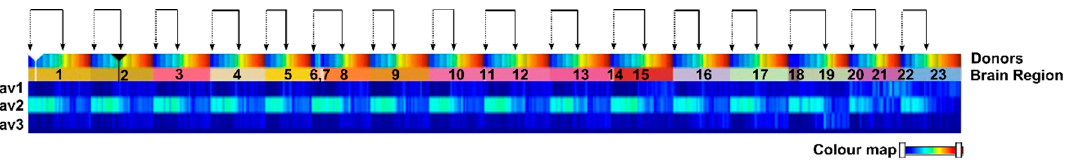
Figure 1. Transcriptional profile of VAV in the developing human brain. VAV expression was analyzed using the developmental transcriptome provided by the Allen Institute for Brain Science, Allen Brain Atlas, Brain Span, Atlas of the developing human brain https://www.brainspan.org (accessed on 4 January 2022). VAV 1, -2 and -3 mRNA intensity is assigned in accordance with the color map derived from data for donor tissue from 8–37 pcw, as indicated by the arrows and represented by the blue-green donors, and 4mth–40 yrs represented by the yellow-dark red donor bars. Data is grouped by brain region with 1 = dorsolateral prefrontal cortex; 2 = ventrolateral prefrontal cortex; 3 = anterior cingulate cortex; 4 = orbital cortex; 5 = primary motor cortex; 6/7 = primary motor-sensory cortex; 8 = primary somatosensory cortex; 9 = posteroventral parietal cortex; 10 = primary auditory cortex; 11 = temporal neocortex; 12 = posterior superior temporal cortex; 13 = inferolateral temporal cortex; 14 = occipital neocortex; 15 = primary visual cortex; 16 = hippocampus; 17 = amygdaloid complex; 18 = medial ganglionic eminence; 19 = striatum; 20 = dorsal thalamus; 21 = medial dorsal nucleus of the thalamus; 22 = upper rhombic lip; 23 = cerebellar cortex.